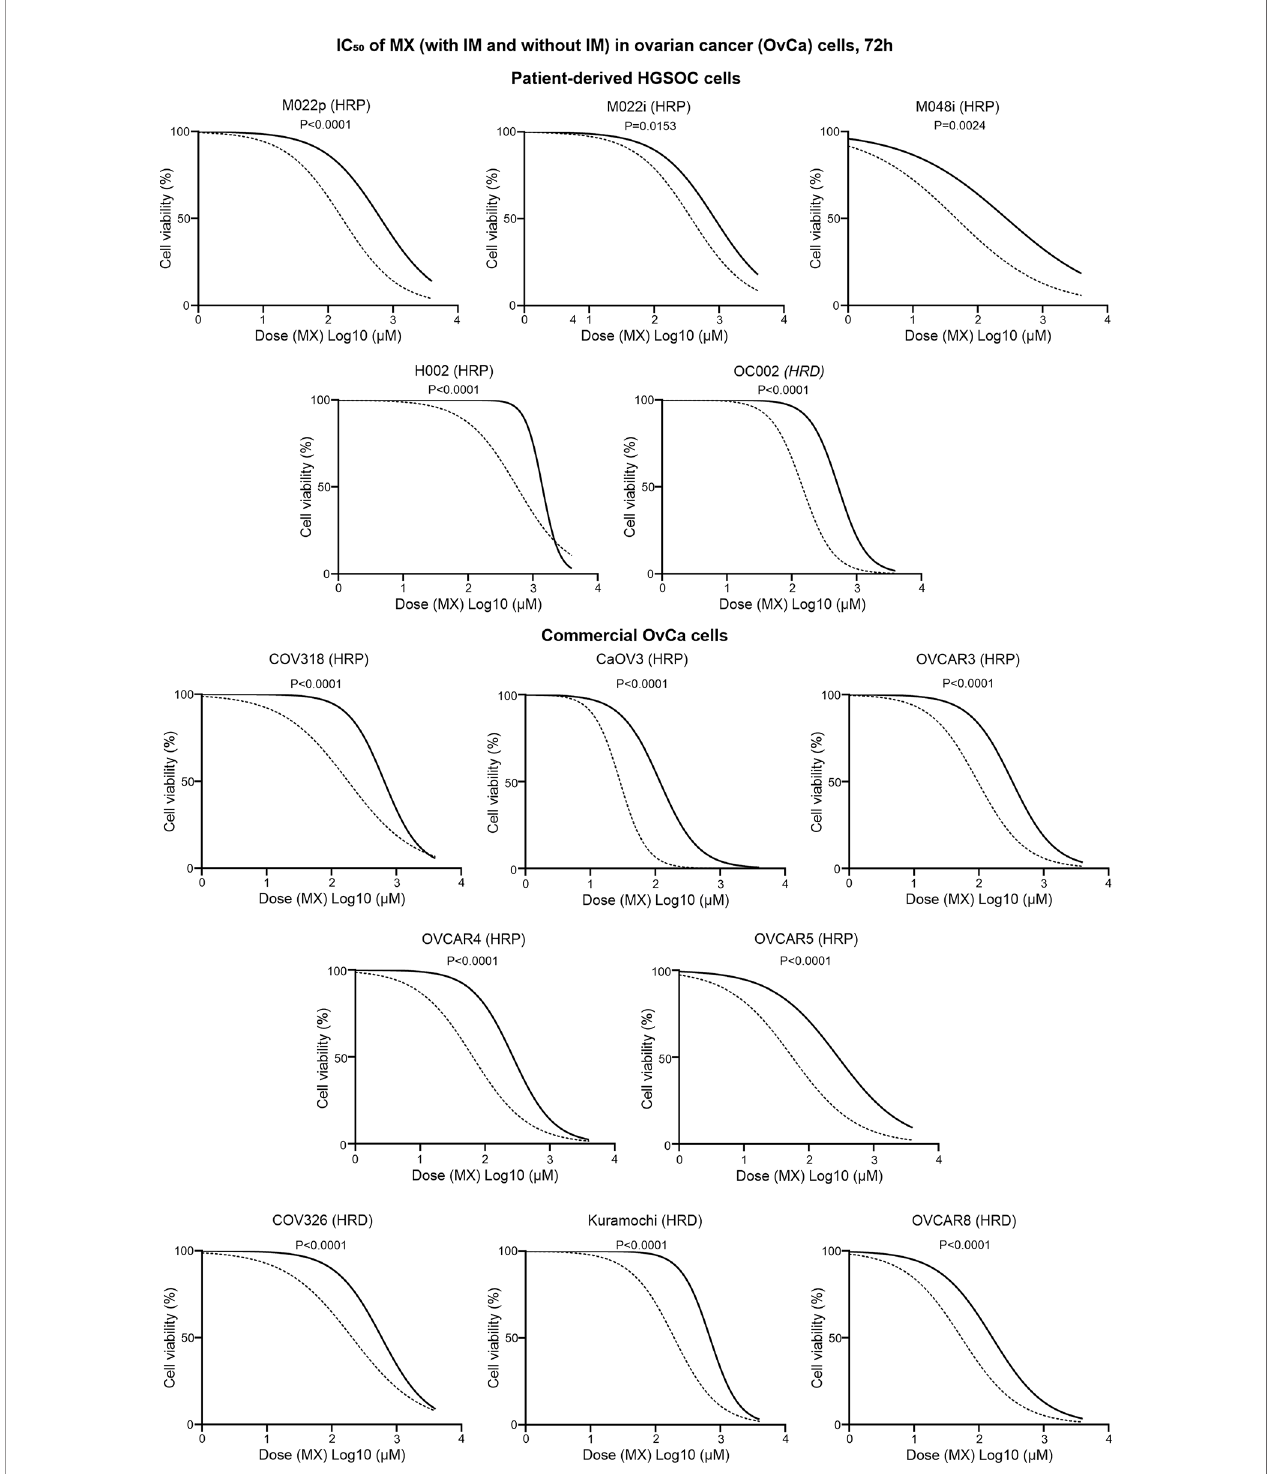
FIGURE 7 | IC 50 values of MX and IMX in ovarian cancer cell lines after 72 h of treatment. The cell lines include fi ve patient-derived HGSOC cell lines (M022p, M022i, M048i, H002, and OC002) and eight commercial HGSOC cell lines (COV318, CaOV3, OVCAR3, OVCAR4, OVCAR5, COV326, Kuramochi, and OVCAR8) with known HR status (either HRP or HRD). The non-linear regression plots show log (inhibitor) vs . normalized response-variable slope where black solid line is MX-only (without IM) and dotted line is MX with 5 µm IM.